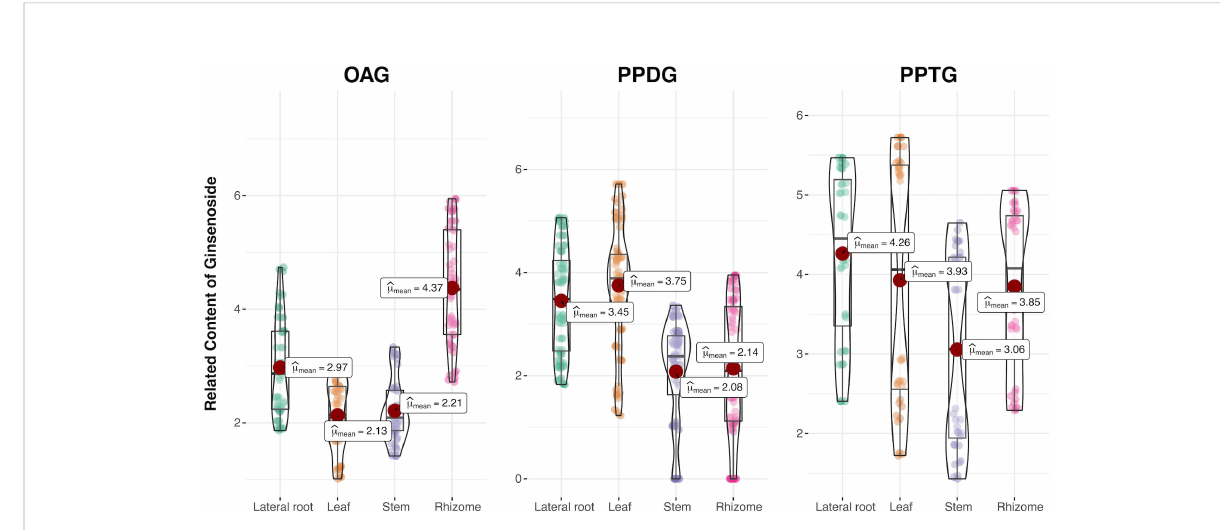
FIGURE 3 Violin plots representing the related content of non-additively accumulated ginsenosides in three types from four tissues of P. japonicus . R ‘ ggstatsplot ’ package was applied and all fi gures include a boxplot as well as a violin plot showing the data distribution. Each box extends from the lower to the upper quartile, and the line in each box represents the mean. The outer line extends to the minimum and maximum data points. The mean represents the accumulation of a certain type of ginsenoside in different